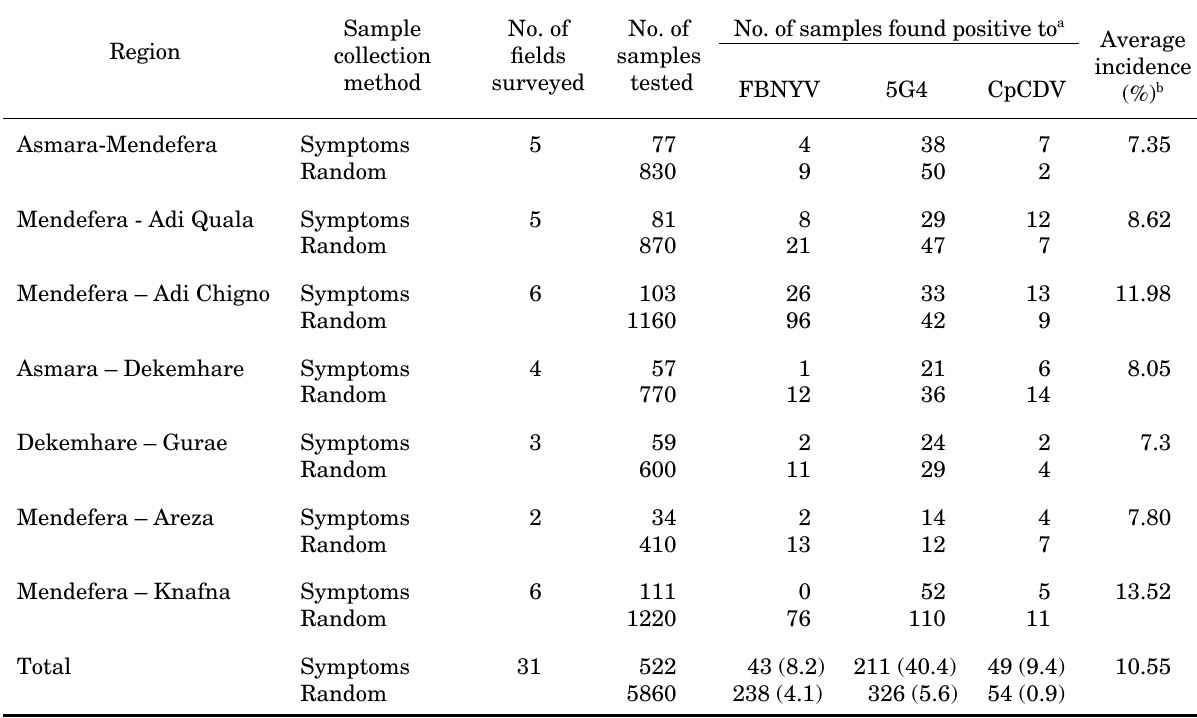
Table 2. Results of laboratory tests on chickpea samples randomly collected or with symptoms suggestive of virus in- fection, from 31 fi elds in Eritrea during November 13–22, 2005. Viral identi fi cation was based on serological reactions (TBIA). Figures in brackets represent virus incidence